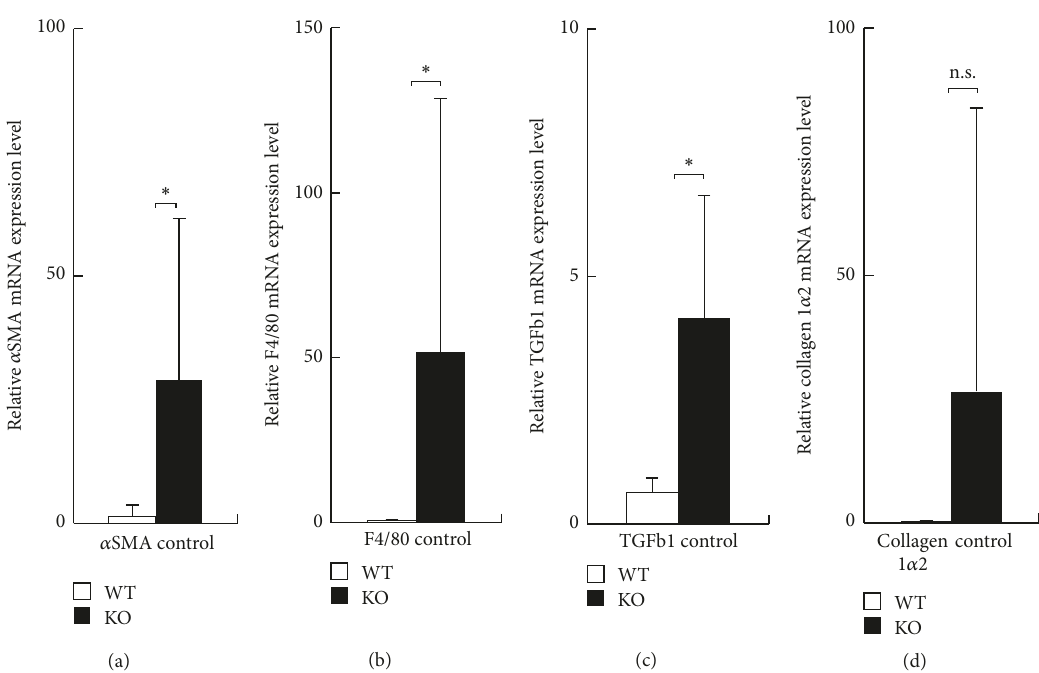
Figure 6: Expression of mRNA of 𝛼 -smooth muscle actin ( 𝛼 SMA), F4/80, transforming growth factor 𝛽 1 (TGF 𝛽 1), and collagen 1 𝛼 2 in normal skin of wild type (WT) and inducible nitric oxide synthase (iNOS-) knockout (KO) mice. (a–c) Expression of 𝛼 SMA, F4/80 and TGF 𝛽 1 mRNA was significantly more marked in KO normal skin compared with WT tissues. (d) Expression level of collagen 1 𝛼 2 mRNA was more prominent in KO normal skin, but there was no significant difference between WT and KO. Open bars: WT, filled bars: KO. Mean ± standard deviation. ∗ 𝑝 < 0.05 ; n.s., not significant.